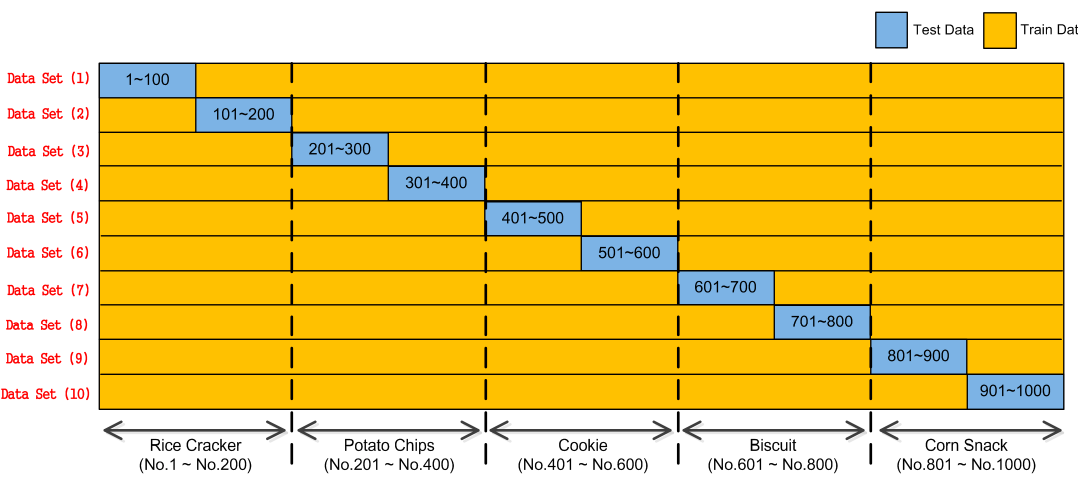
Figure 13. Data Sets (1) – ( 10 ) employed for the neural network model validation.